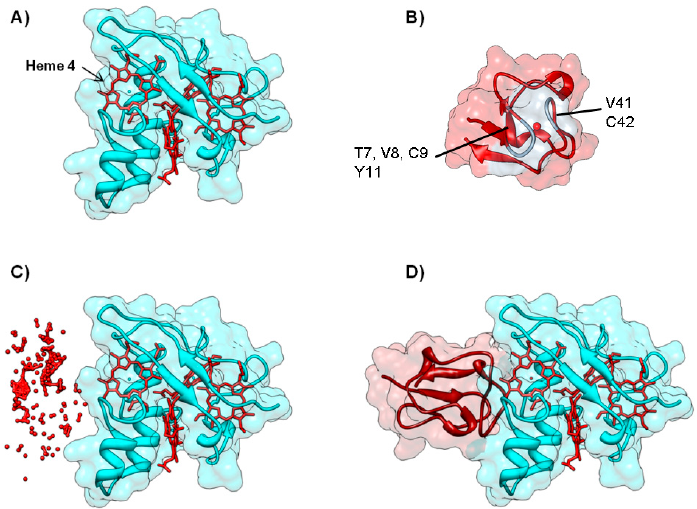
Figure 7. Electron transfer complex between cytochrome c 3 and rubredoxin from D. gigas . Panels ( A ) and ( B ) depict the backbone structure of the cytochrome c 3 and rubredoxin, respectively. Metal centers ( c -type heme for cytochrome c 3 and Fe for rubredoxin) are represented in red. Rubredoxin residues whose N H resonances are most affected in a 1 H- 15 N HSQC NMR titration are shown in light grey; Panel ( C ) The top 200 docking solutions ranked by electrostatic energy minimization score of the cytochrome c 3 —rubredoxin electron transfer complex. The iron atom of each rubredoxin putative docking position is represented as a red sphere; Panel ( D ) Top model structure for the electron transfer complex obtained by BiGGER is represented. Cytochrome c 3 is colored cyan and rubredoxin is colored dark red. Figures prepared using UCSF Chimera [69].